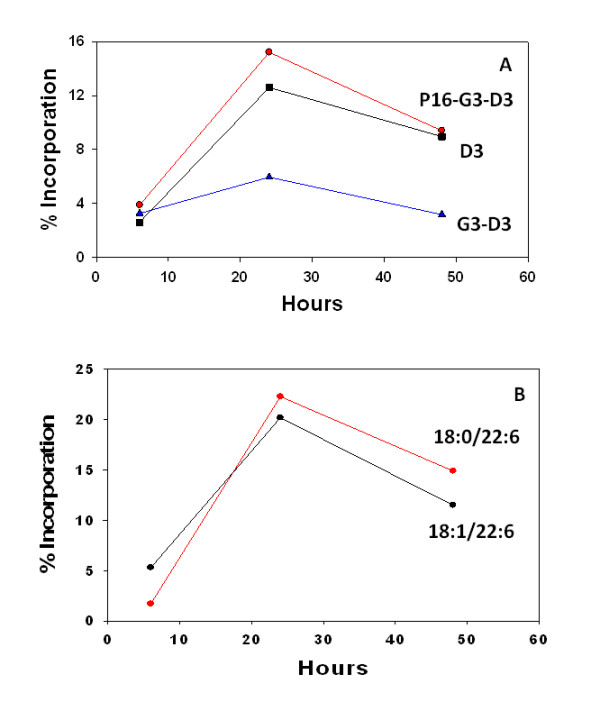
Incorporation of [13C22]PPI-1038 into plasma DHA-containing ethanolamine plasmalogens (PlsEtn) 6, 24 and 48 hours after an oral dose of 100 mg/kg in a gelatin capsule. N = 1 rabbit. Figure A, Labeling of PlsEtn 16:0/22:6 (D3, [13C3]DHA; G3, [13C3]glycerol; P16, [13C16]palmitic acid); Figure B, [13C3]DHA labeling of PlsEtn 18:0/22:6 and PlsEtn 18:1/22:6.